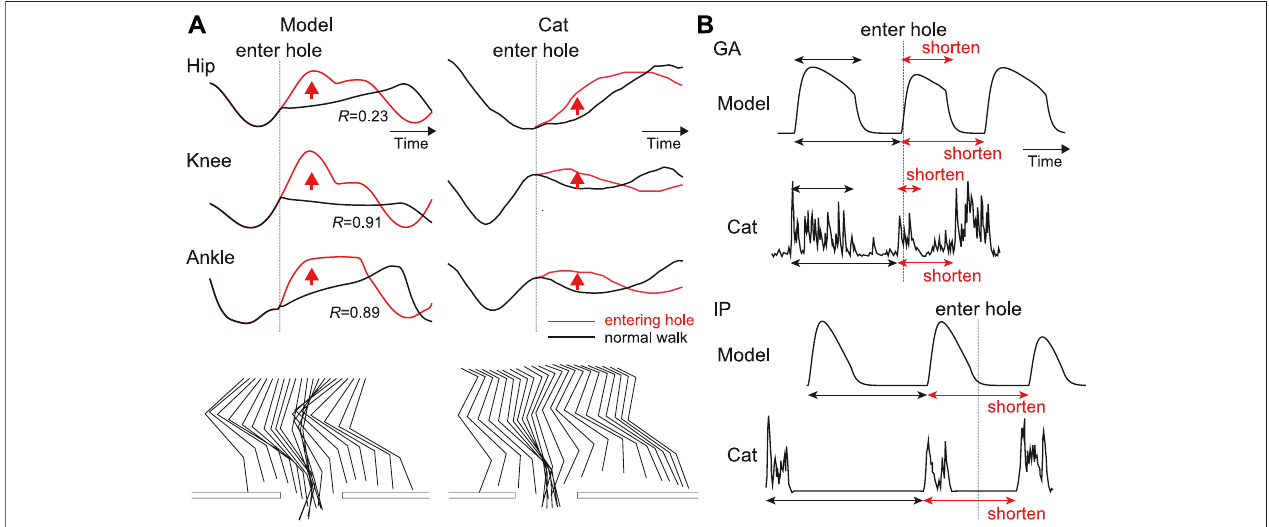
FIGURE 6 | Simulation results when on paw enters a hole compared with those during normal walking: (A) Joint angles and stick diagrams compared with measured data [adapted from Hiebert et al. (1994) for entering a hole and from Prilutsky et al. (2016) for normal walking]. These data are shown from the liftoff before entering a hole to the touchdown after entering the hole. R is the correlation coef fi cient of the results after entering the hole. The stick diagrams are shifted to the left by according to the distance traveled by the treadmill belt. (B) Activities of IP and GA muscles compared with measured data in spinal cat [adapted from Hiebert et al. (1994)]. Upper arrows indicate the activity duration, and lower ones indicate the intervals between the onsets of current and subsequent